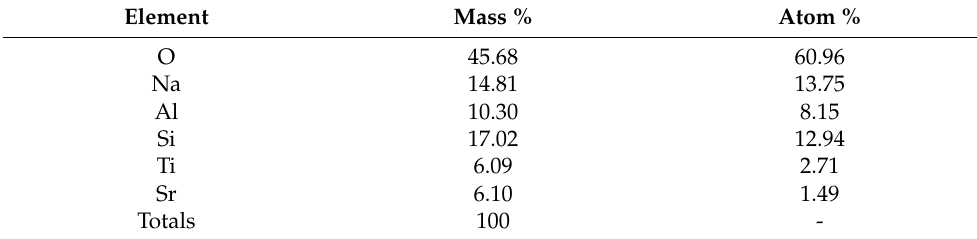
Table 2. Elemental analysis for TiO 2 /Sr 4 Al 14 O 25 :Eu 2+ ,Dy 3+ photocatalyst/phosphor beads. Element